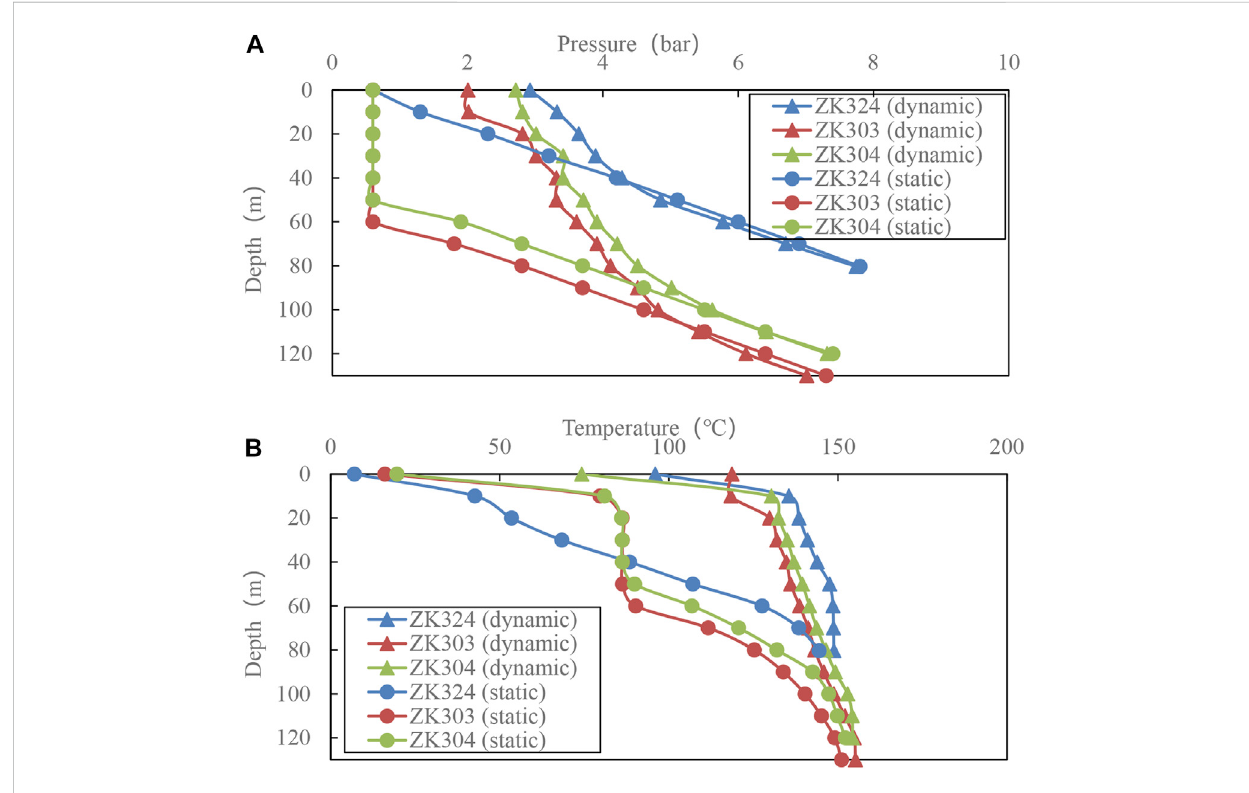
FIGURE 3 Temperature and pressure test results, (A) pressure, (B) temperature.